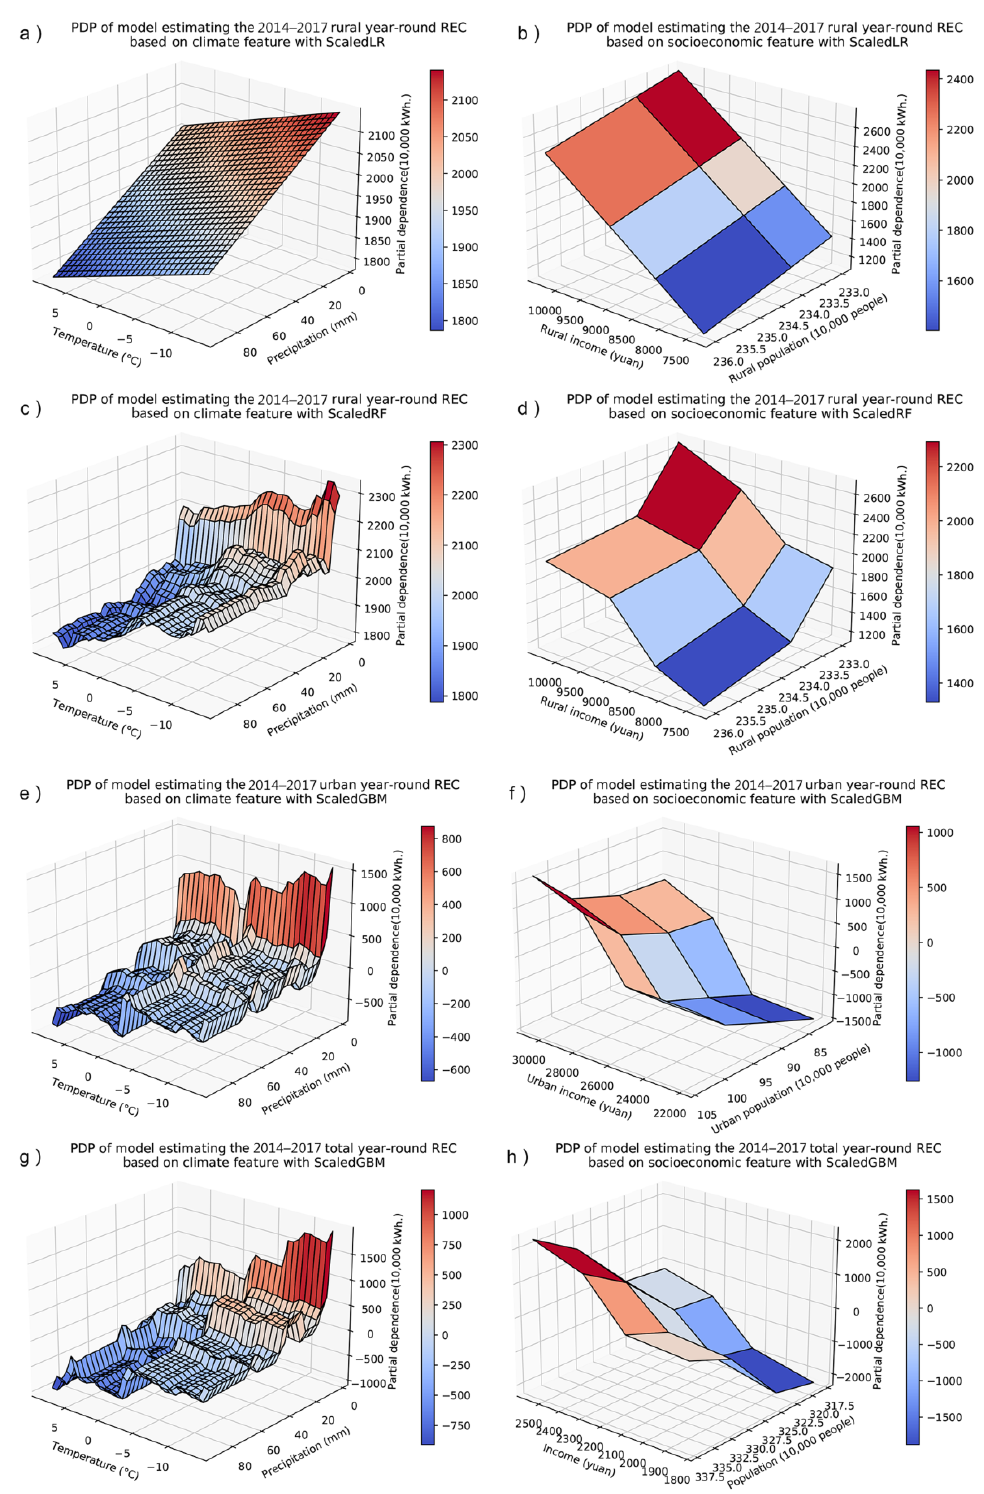
Figure 5. Climatic and socioeconomic effects on Tibet’s REC. All plots are partial dependence plots (PDPs), with the color panel indicating how much the respective feature contributes to the REC estimation of the respective model. Plots ( a , c , e , g ) are PDPs of climate features and plots ( b , d , f , h ) are PDPs of socioeconomic features. Plots ( a , b ), ( c , d ), ( e , f ), and ( g , h ) present the results of the linear rural model, tree-based rural model, urban model, and total model, respectively.